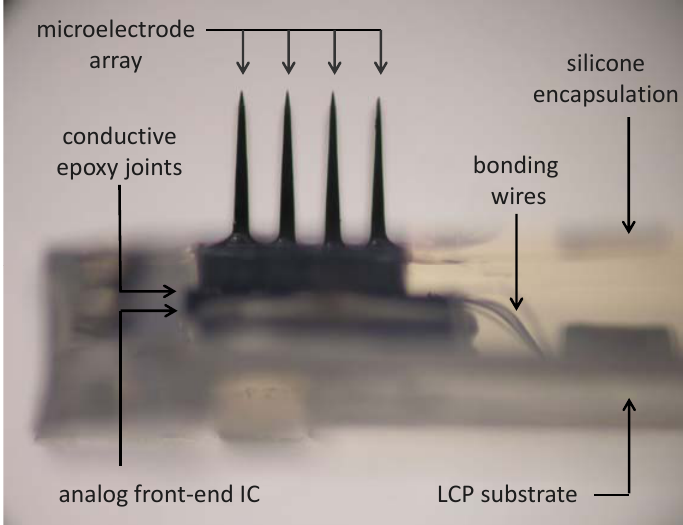
Figure 3. A photographic view of the front-end integrated unit after silicone encapsulation is shown. The height of the microelectrodes serves as a scale bar with a length of 1.5